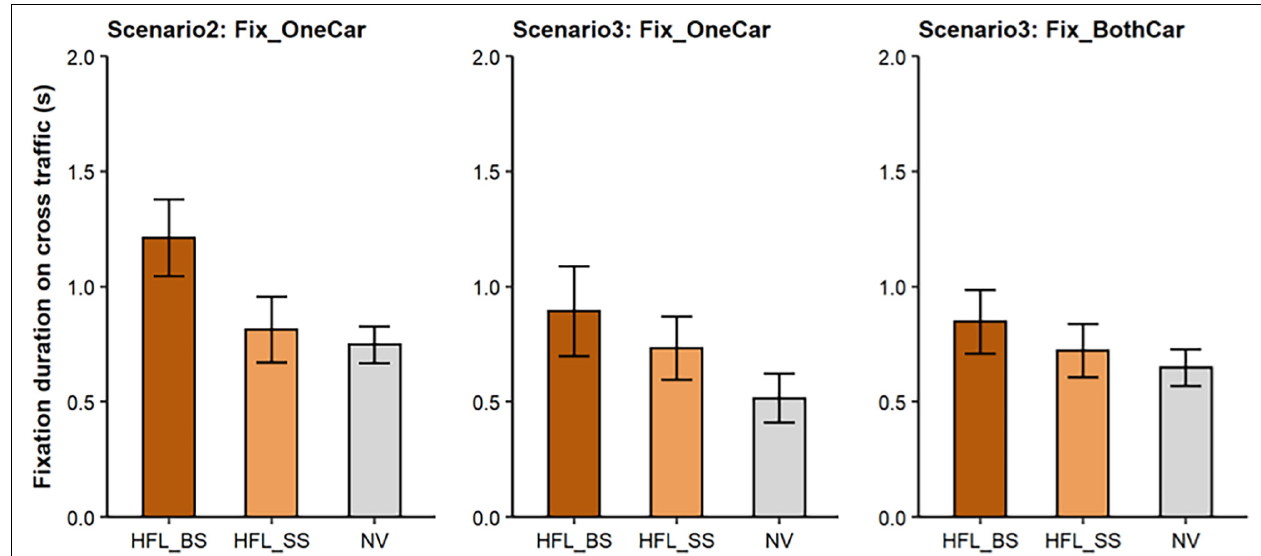
FIGURE 4 | Mean fixation durations on cross-traffic cars on the HFL group’s blind side (HFL_BS), seeing side (HFL_SS), and for the NV group (average across left and right sides). Left- Scenario 2 (cross traffic from one side only): in cases when participants fixated on the cross traffic from the one side. Middle- Scenario 3 (cross traffic from both sides): in cases when participants fixated only on cross traffic approaching from one side. Right - Scenario 3: in cases when participants fixated on cross traffic approaching from both sides. Error bars represent SEM.